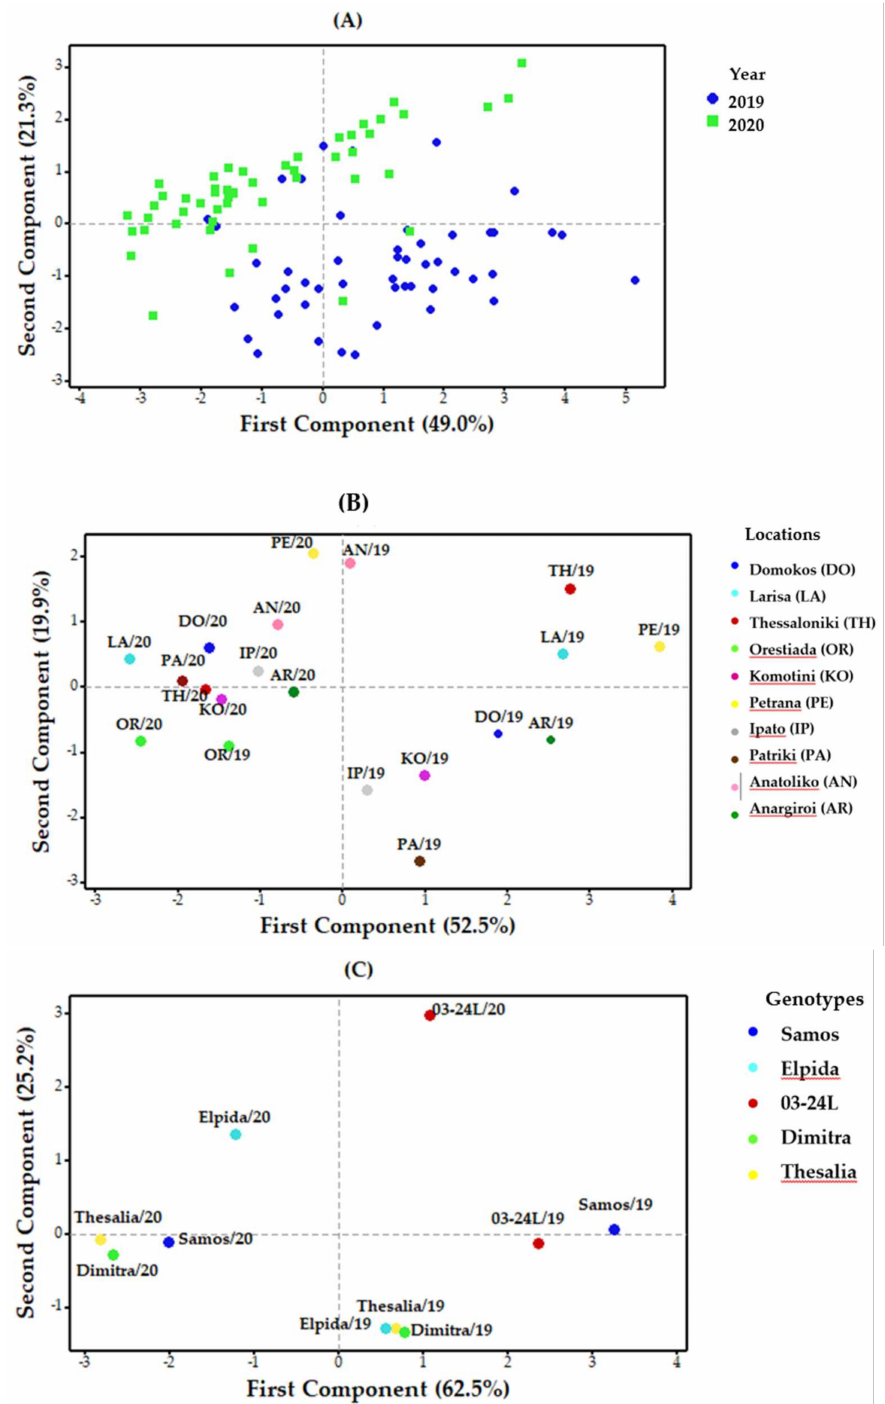
Figure 4. Principal component analysis loading plots of the phytochemical variables (total phenolic content, total flavonoids content, total proanthocyanidins content, total hydrolyzed tannin content) and antioxidant activity as evaluated by ABTS, DPPH and FRAP methods of the lentil seeds grown under twenty different environments (N = 150), ( A ) in respect to year, ( B ) in respect to growing location per year and ( C ) in respect to genotype per